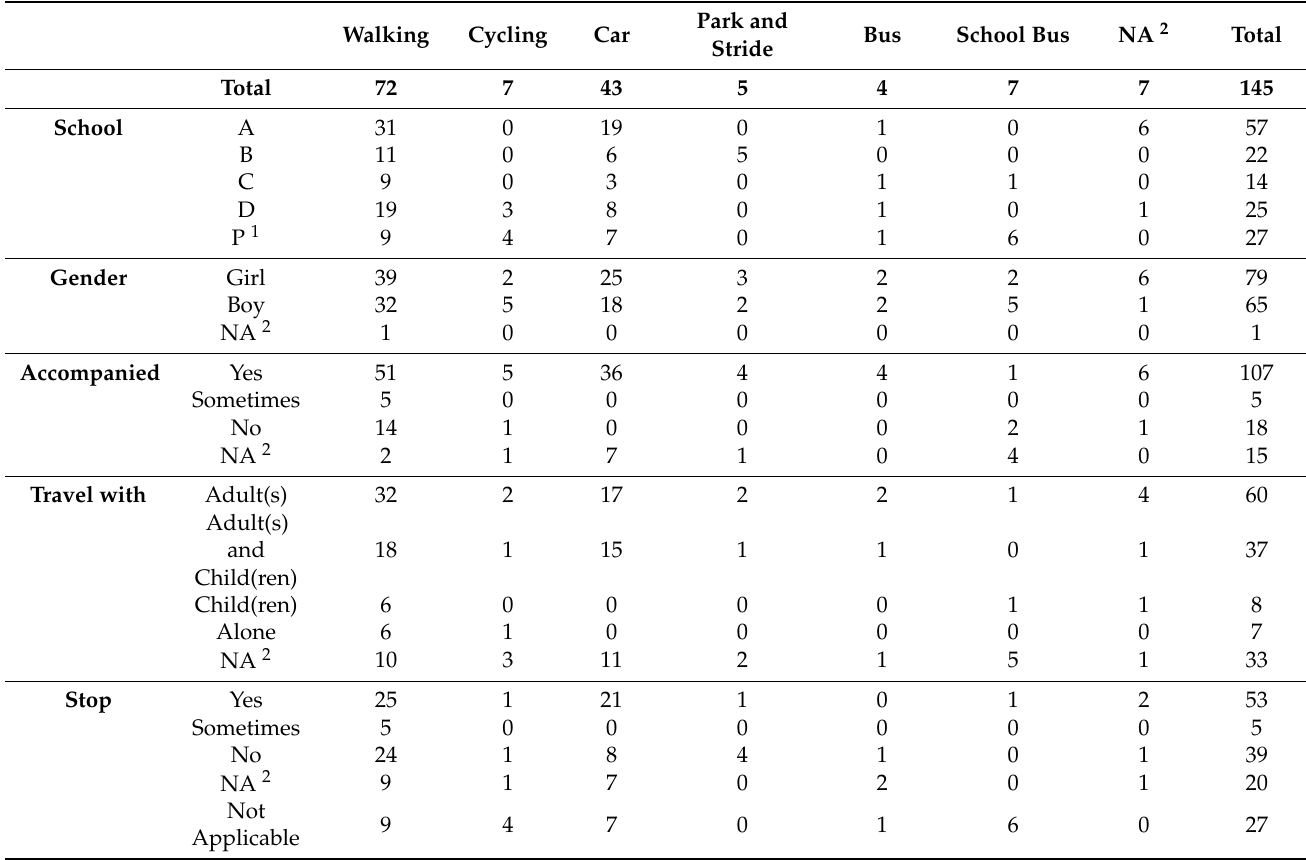
Table 1. Participants’